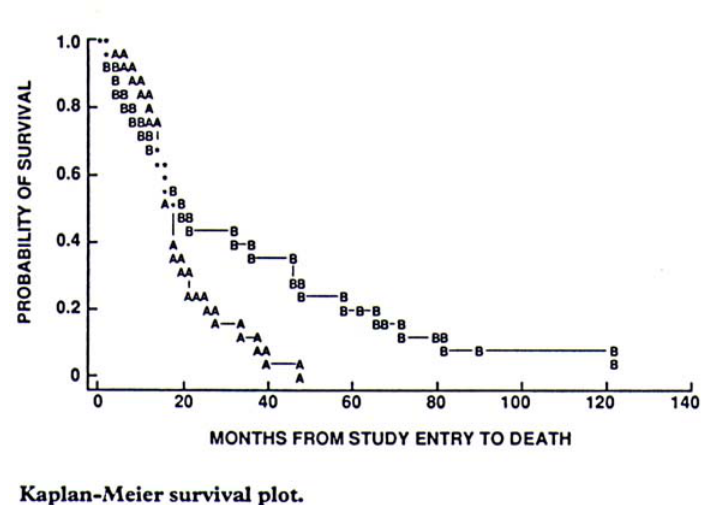
FIGURE 1 . A group of women with metastatic breast cancer worked to improve their quality of life for 90 min a week for a year and on average they survived twice as long as the controls who did not work systematically to improve their